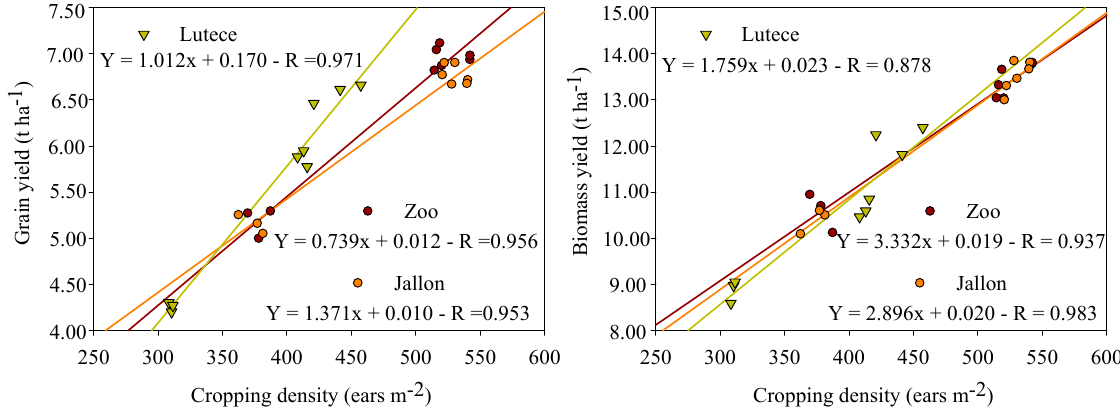
For each treatment, different letters on the same row indicate significative differences according to Tukey’s Test HSD at p ≤ 0.05.